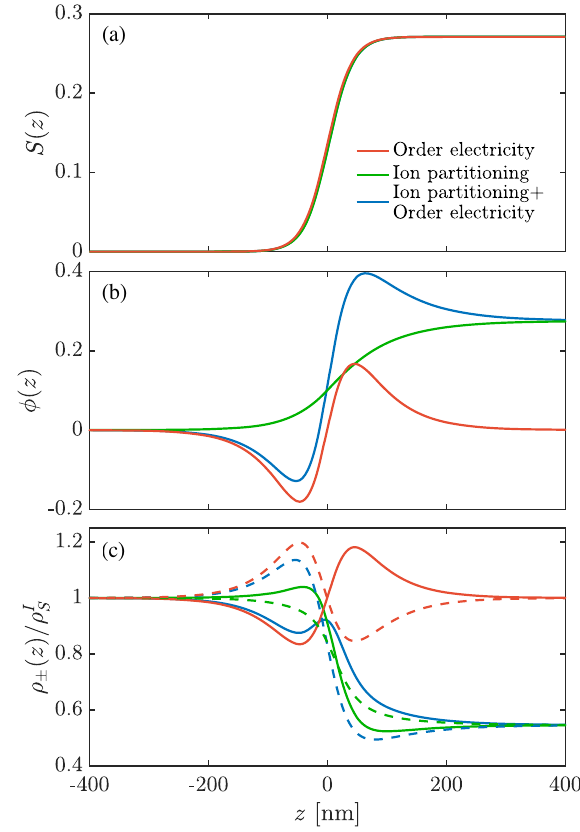
FIG. 2. Electric double layer of flat isotropic nematic interface (positioned at z ¼ 0 ). We show the effect of order electricity and ion partitioning on (a) the order parameter profile S ð z Þ , (b) the dimensionless electrostatic potential ϕ ð z Þ , and (c) the ion densities for anions ρ − ð z Þ (solid lines) and cations ρ ð z Þ (dashed þ lines). In all plots, we use κ − 1 ¼ 50 nm, which results in a bulk I 4 . 4 × 10 − 6 M, and the ion density in the isotropic phase ρ I s ¼ nematic correlation length is ξ ¼ 20 nm. When order electricity G ¼ is included, we use the order-electric coefficient q e 1 pCm − 1 , and when ion partitioning is included, we use g ¼ 3 þ and g − ¼ 8